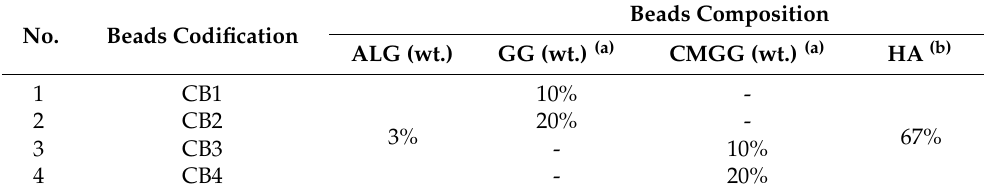
Table 1. CBs codification and composition.